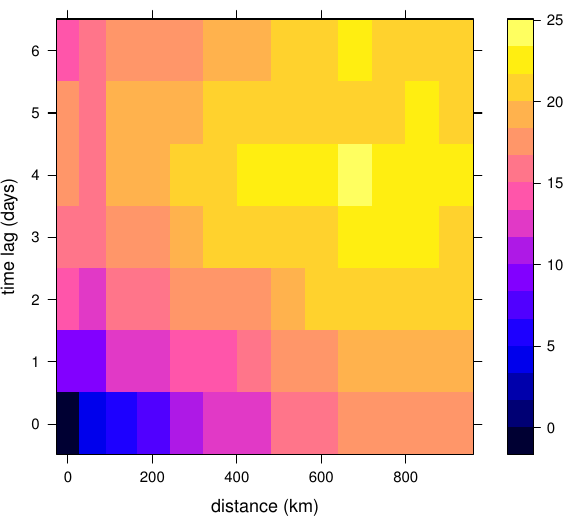
Figure 3. Huber’s spatio-temporal semivariogram estimator (with tuning constant equal to 1.345) of daily Tmax from the NOAA data set for July 2003, computed using the estimator introduced in Section 6.